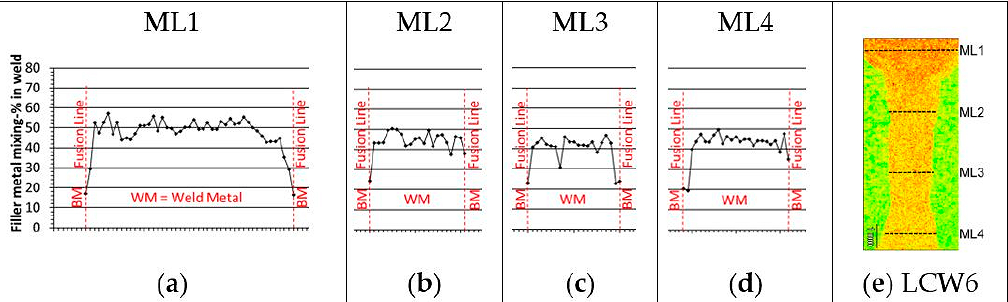
Figure 17. Filler metal mixing results from EDS stepwise characterization. ( a – d ) Filler metal mixing-% profiles of measurement lines 1–4 (ML1–ML4) from test weld LCW6 ( e ). In figures ( a – d ) one step between adjacent measurement points in the horizontal axis equals 100 micrometres.